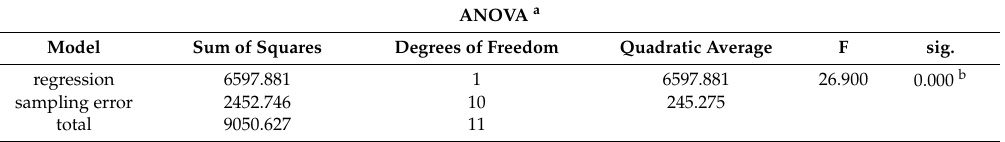
Table 15. Variance analysis for wheel-tracking test and second modulus of PLT ( Φ 600mm) at crown.